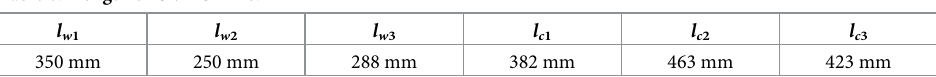
Table 6. Length of UVMS links.